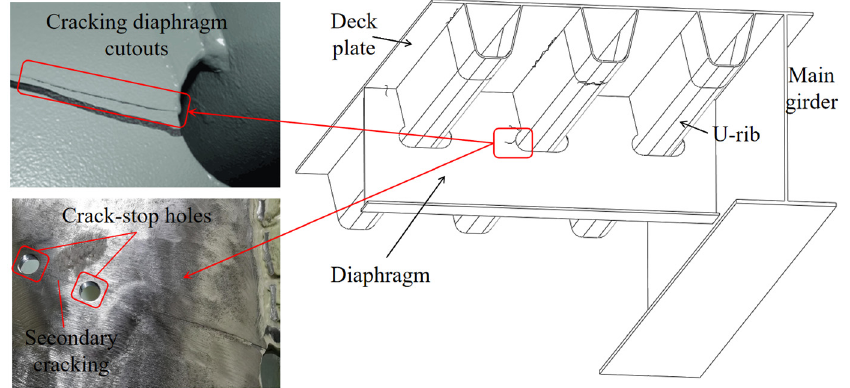
Figure 11. Fatigue cracking of the diaphragm cutouts in orthotropic steel bridge decks.